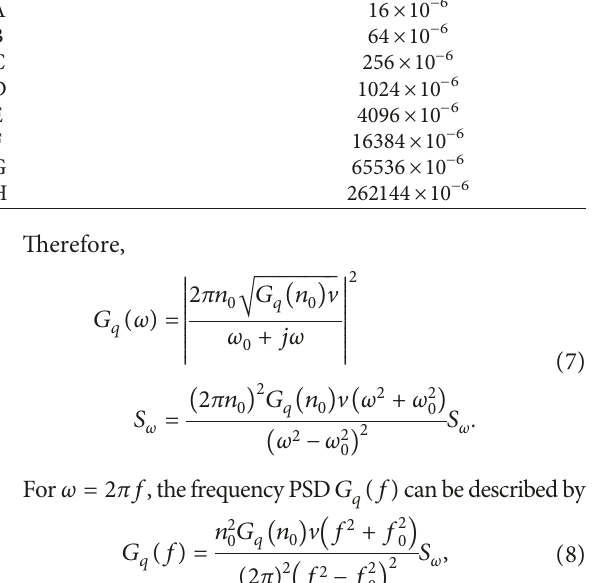
Table 1: Classification standards of road roughness. Road roughness